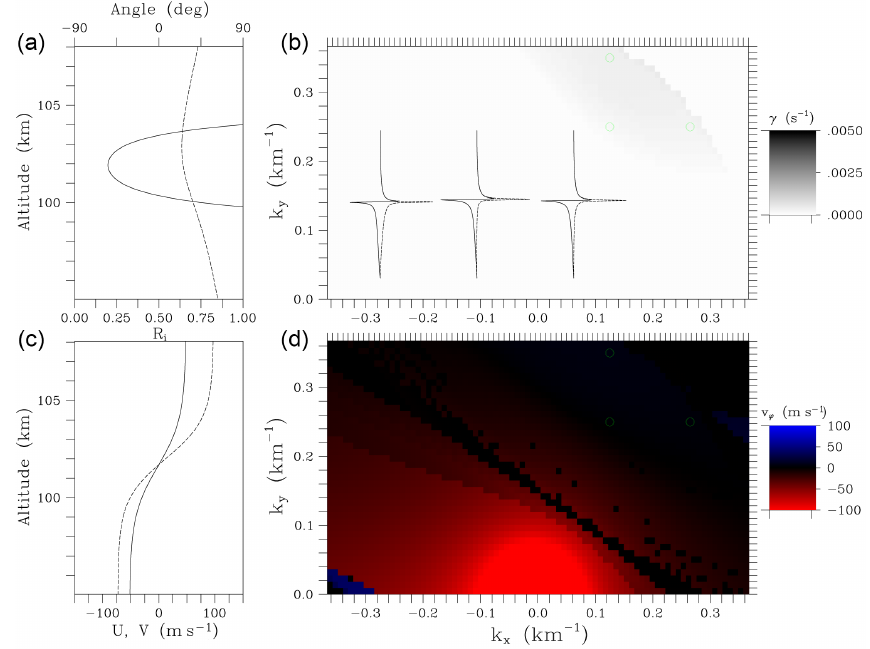
Figure 7. Eigenfunction analysis for wind profiles in first patchy E s layer. (a) Minimum Richardson number parameter and propagation angle at which the minimum occurs. (b) Linear growth rate of the fastest-growing eigenmode with some representative mode shapes. (c) Zonal (solid) and meridional (dashed) wind profiles. (d) Phase speed of fastest-growing mode.